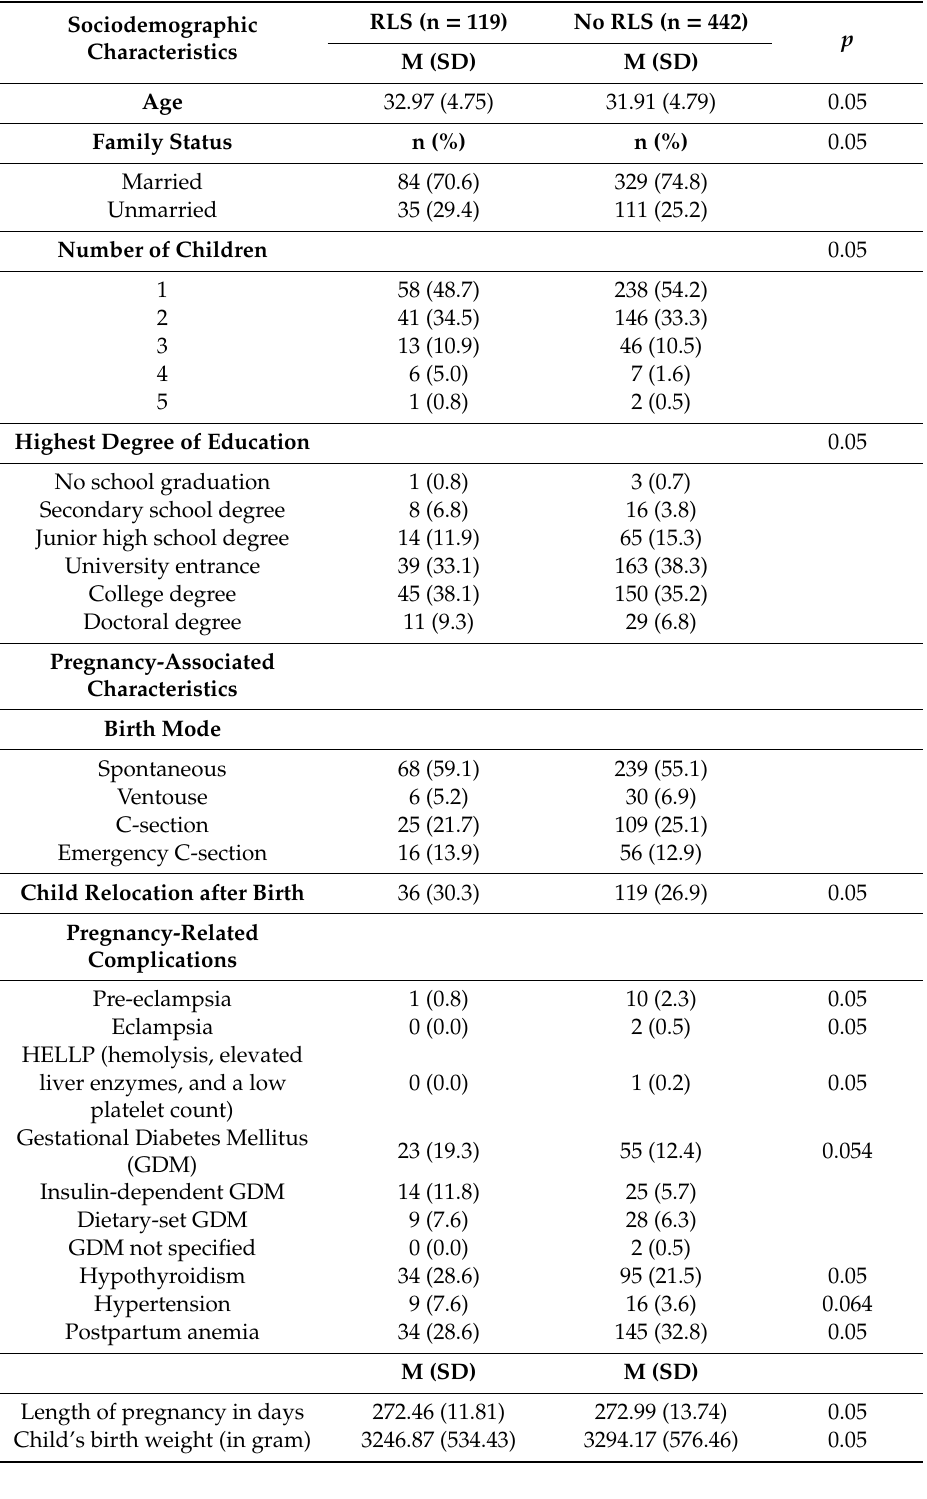
Table A3. Di ff erences between women with RLS (n = 119) and women without RLS (n = 442).